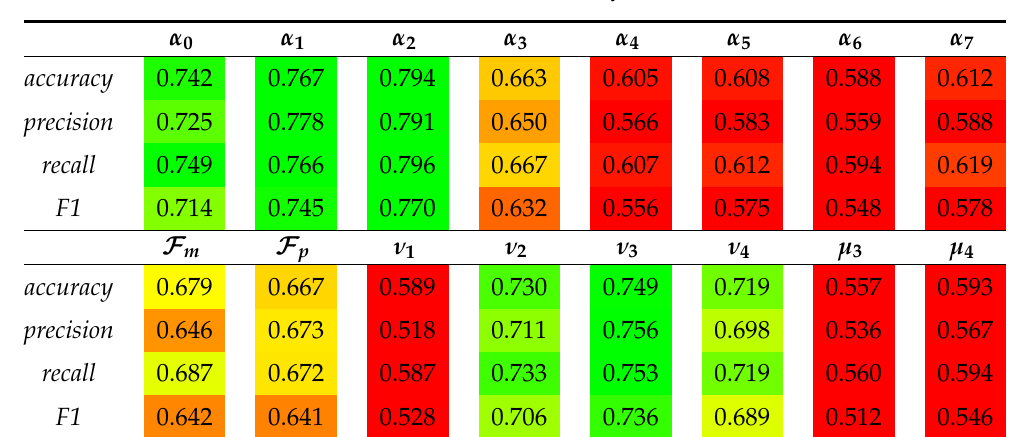
Figure 6. Mean values of the selected metrics for different ROI groups. Table 1. Values of the selected metrics obtained for the analyzed